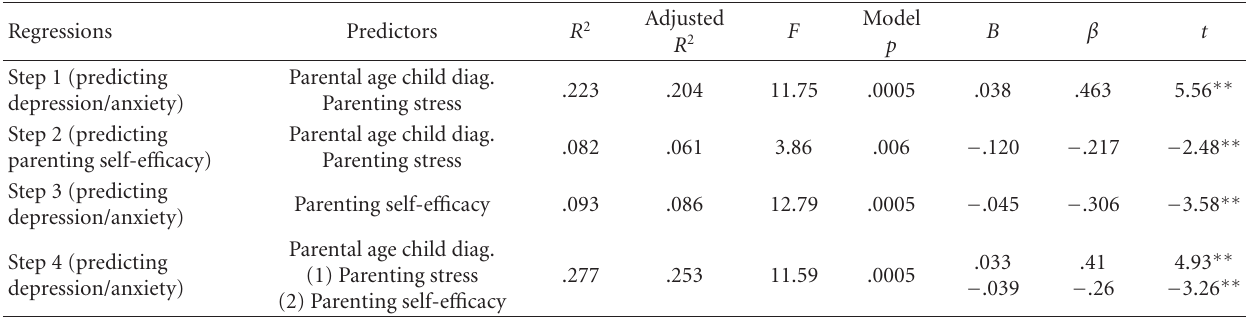
Table 4: Analysis of self-e ffi cacy as a mediator between parental stress and parental